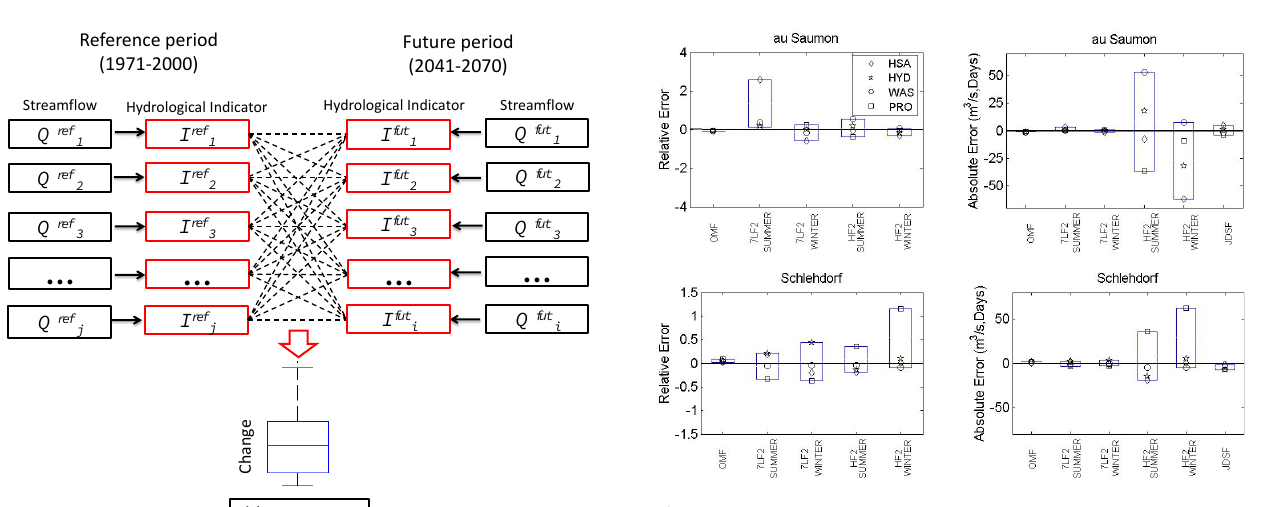
Fig. 5. Performance of the hydrological models over the reference period. The left panels show the relative error as computed with Eq. (1), while the right panels show the absolute error in m 3 s − 1 or